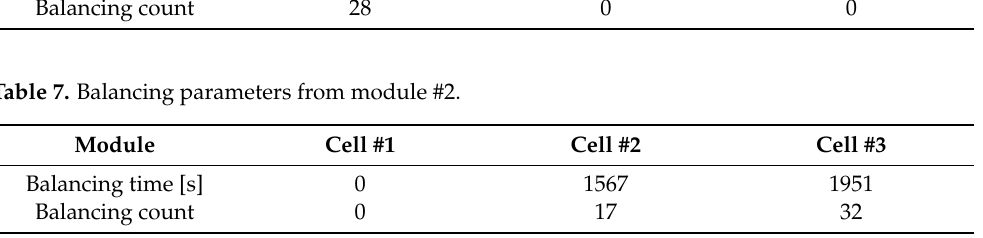
Figure 6. Experimental results from module #2. Table 7. Balancing parameters from module #2.